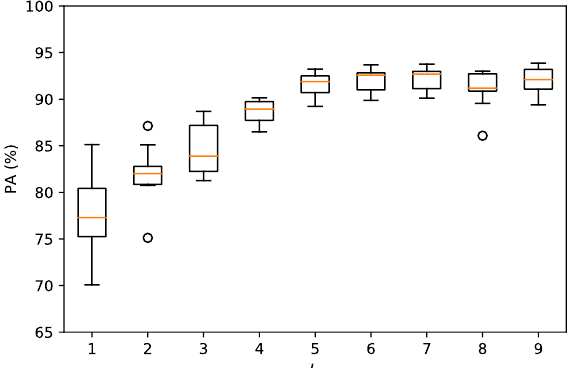
Figure 5. Box and whiskers plot of the pixel accuracy (PA) for the 10 testing scenarios shown in Table